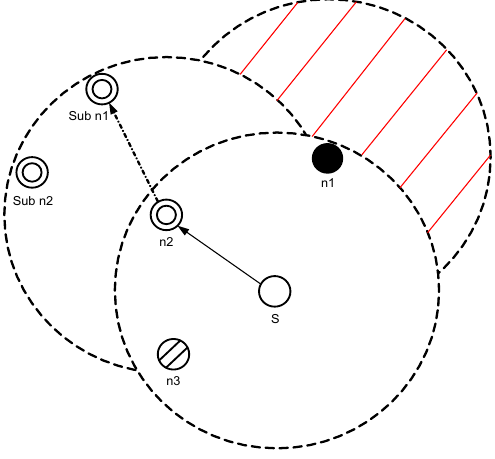
Figure 4. Next hop forwarder